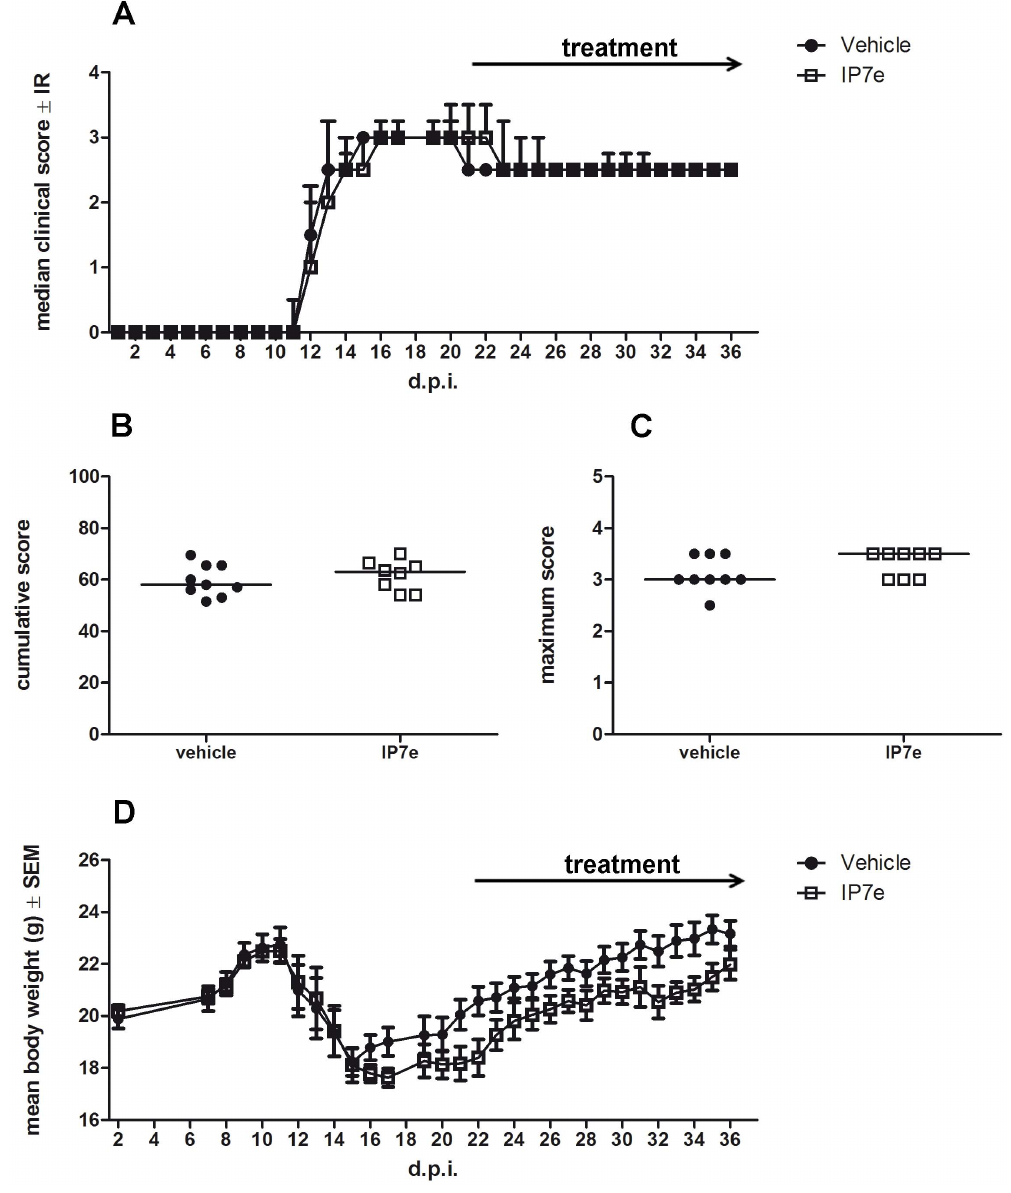
Figure 4. Therapeutic administration of IP7e does not influence the severity of EAE. The clinical course of EAE in IP7e (n=8) and vehicle (n=9) –treated EAE mice is compared. The analysis does not show any difference of disease severity i.e. median course (A), cumulative (B, bar represents median value) and maximum (C, bar represents median value) clinical score and weight loss (D) after the therapeutic administration of IP7e in EAE mice. Arrows indicate the period of treatment (from 21 th to 36 th d.p.i.). Data are representative of 2 independent experiments. (Two Way ANOVA, Student’s t test). (d.p.i.; day post immunization, IP7e; isoxazolo-pyridinone 7e, IR; interquantile range, SEM; standard error of mean).